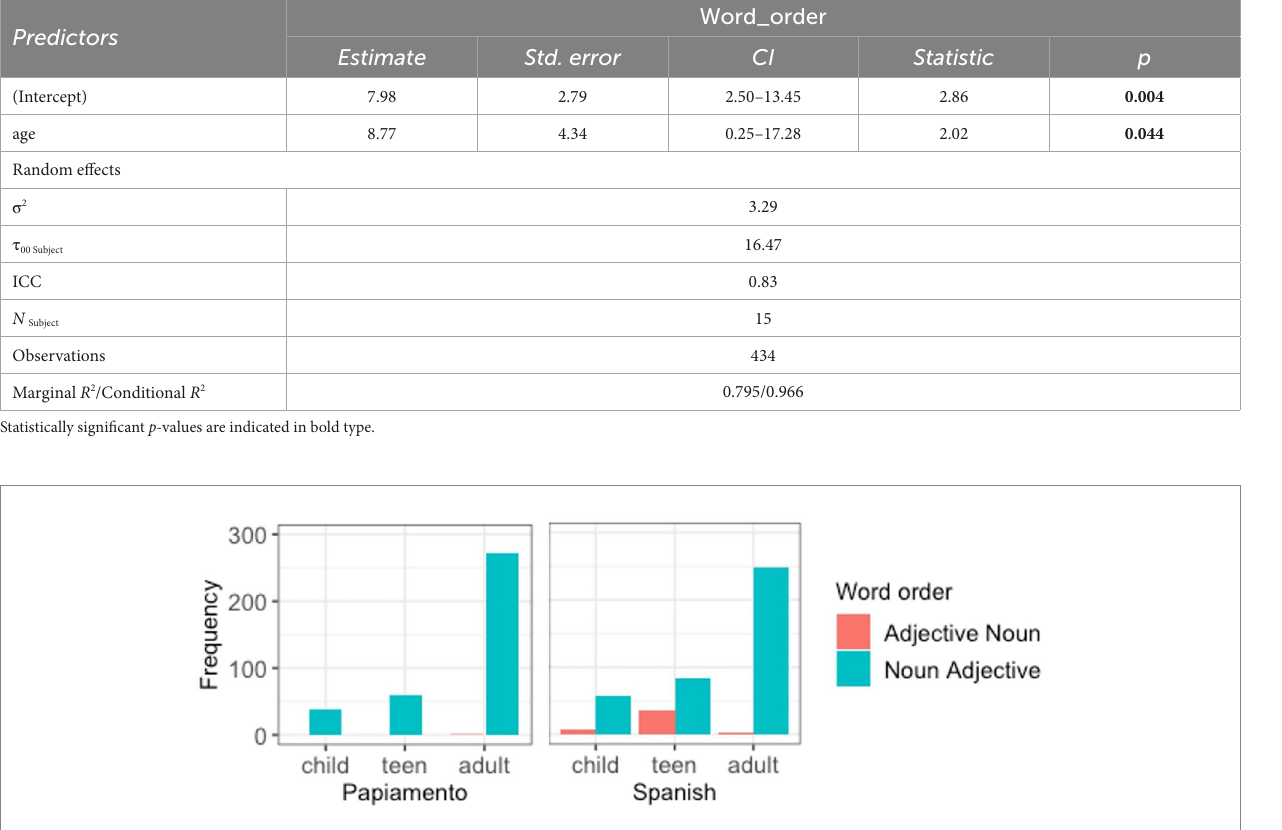
FIGURE 6 Word order preference for Spanish/Papiamento as a matrix language, by age group by heritage